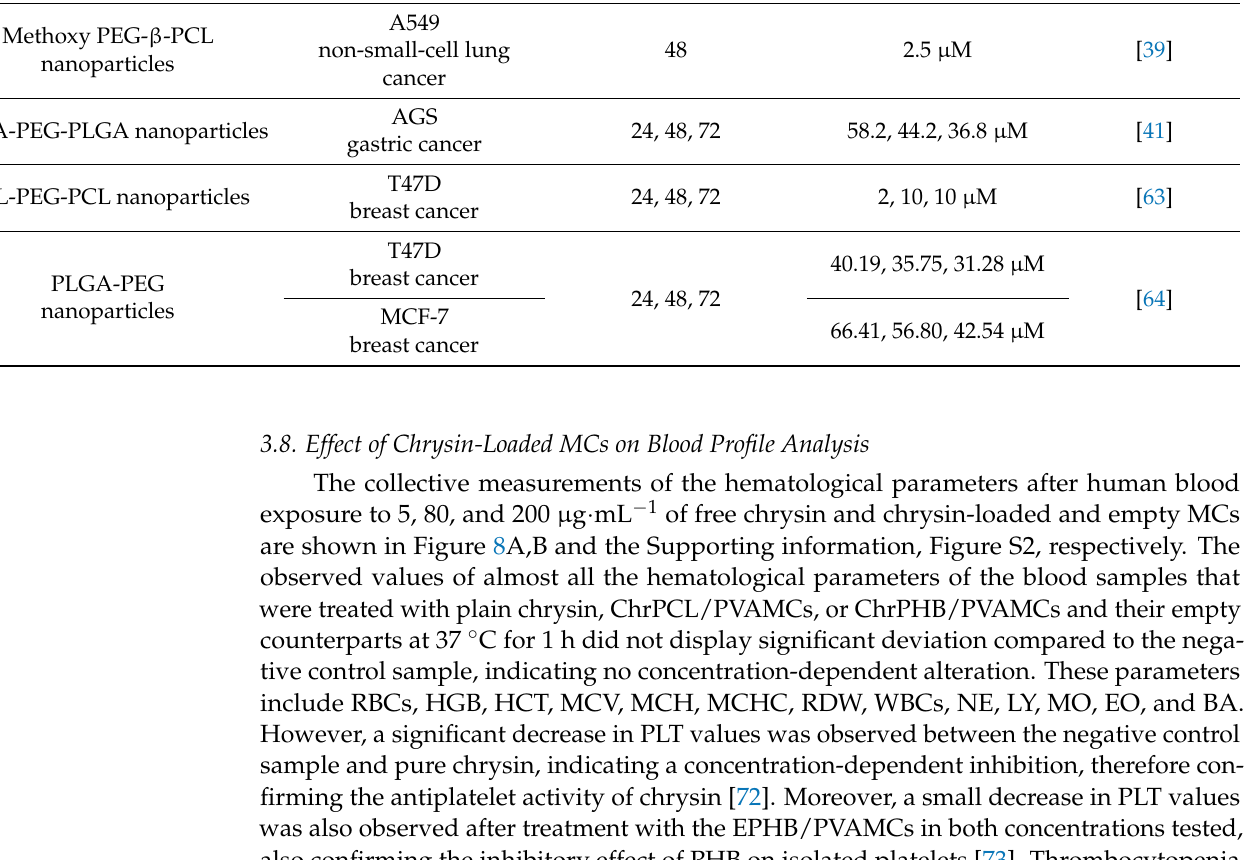
Table 2. Data reported in the literature on cytotoxic IC 50 values of chrysin-loaded nano-formulations. Type of